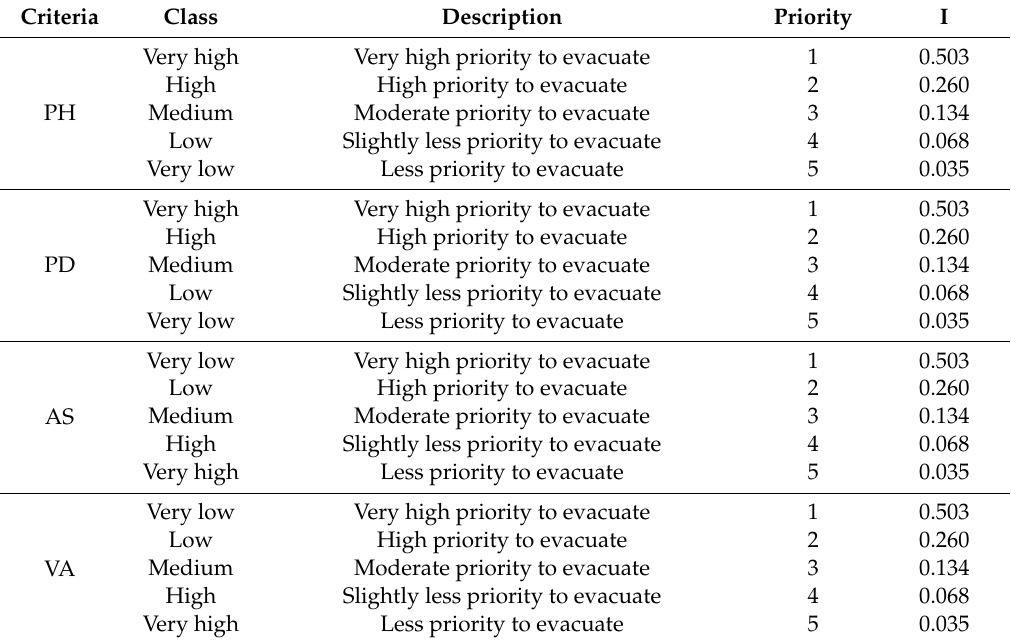
Table 1. Criteria and attributes value for the priority design.